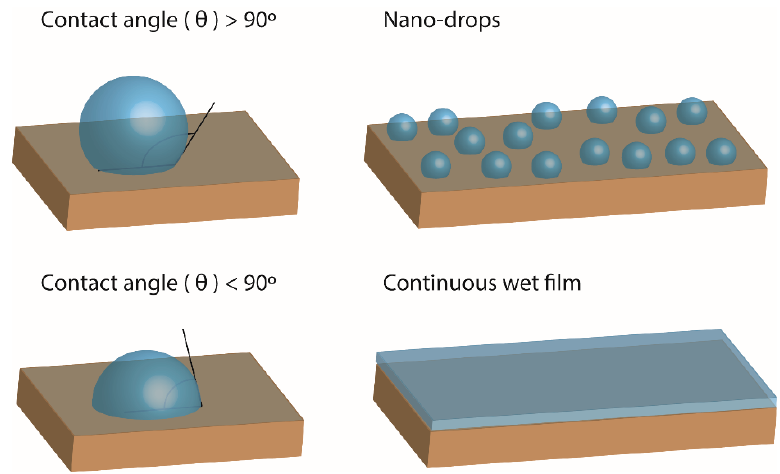
Figure 2. Schematic of the influence of surface free energy on the arrangement of the catalyst solution during the dip-coating process.